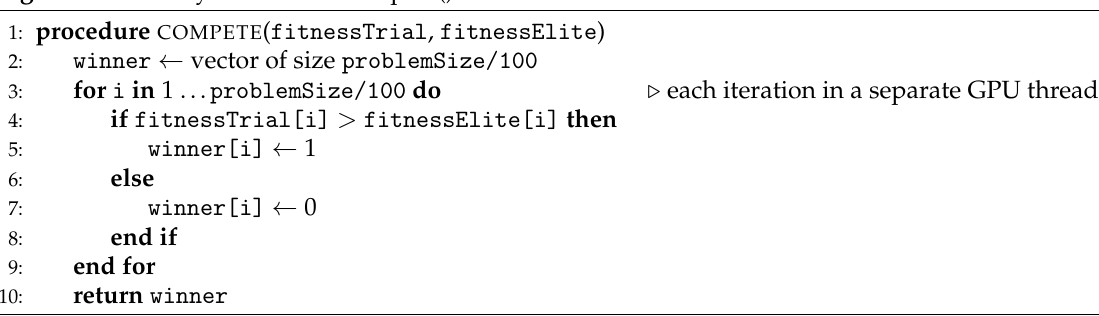
Algorithm 4 Binary cGA-A100: compete().